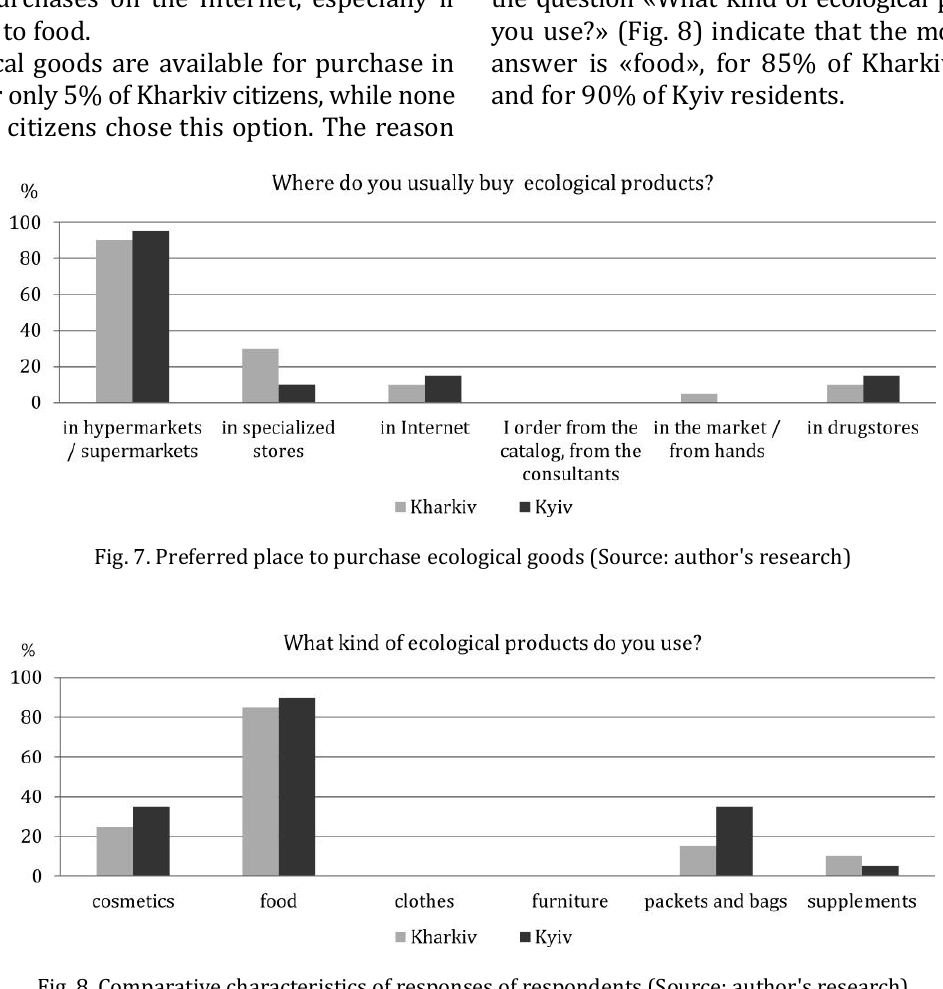
Fig. 8. Comparative characteristics of responses of respondents (Source: author's